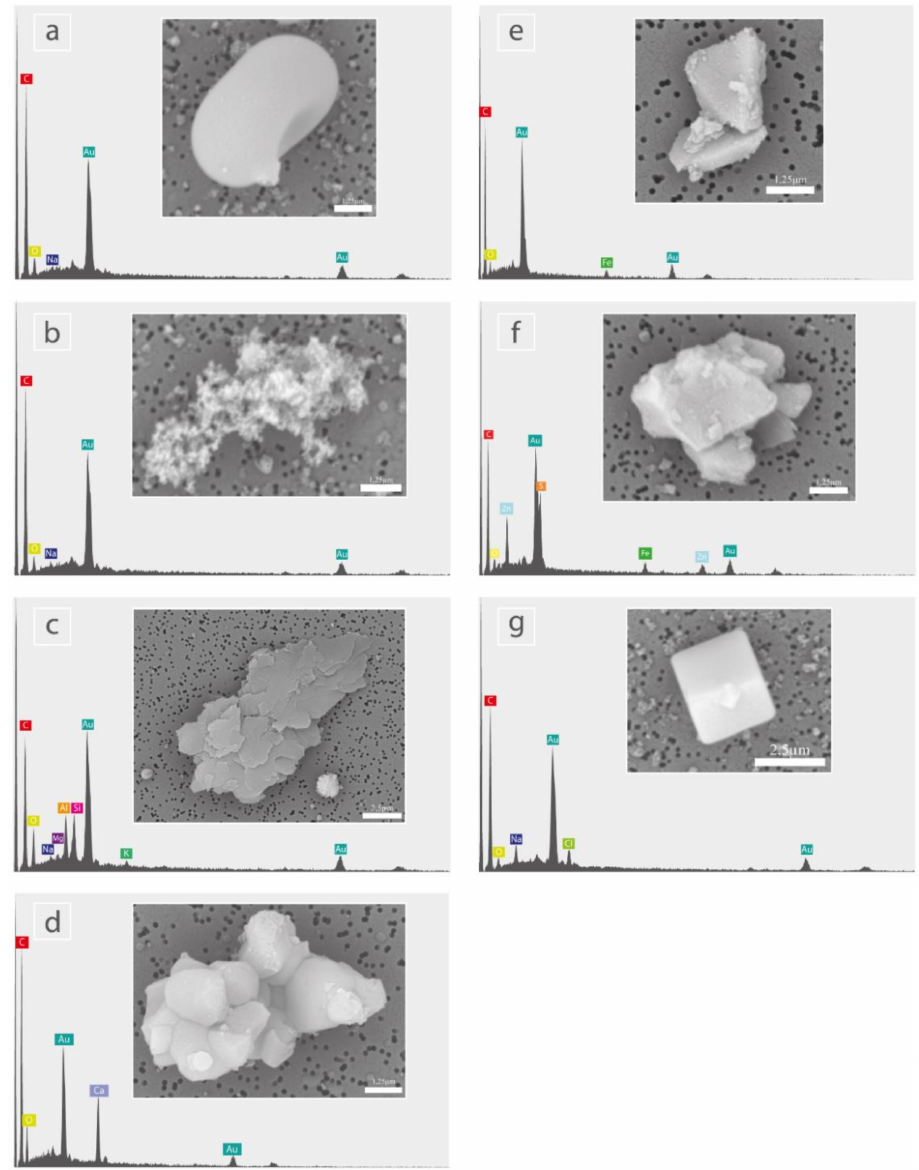
Figure 5. Examples of all the types of atmospheric particles identified: ( a ) biogenic particle ( b ) soot; ( c ) silicate particles; ( d ) carbonate particle—calcite; ( e ) Fe-oxide particle; ( f ) sulfide particle—sphalerite and ( g ) marine